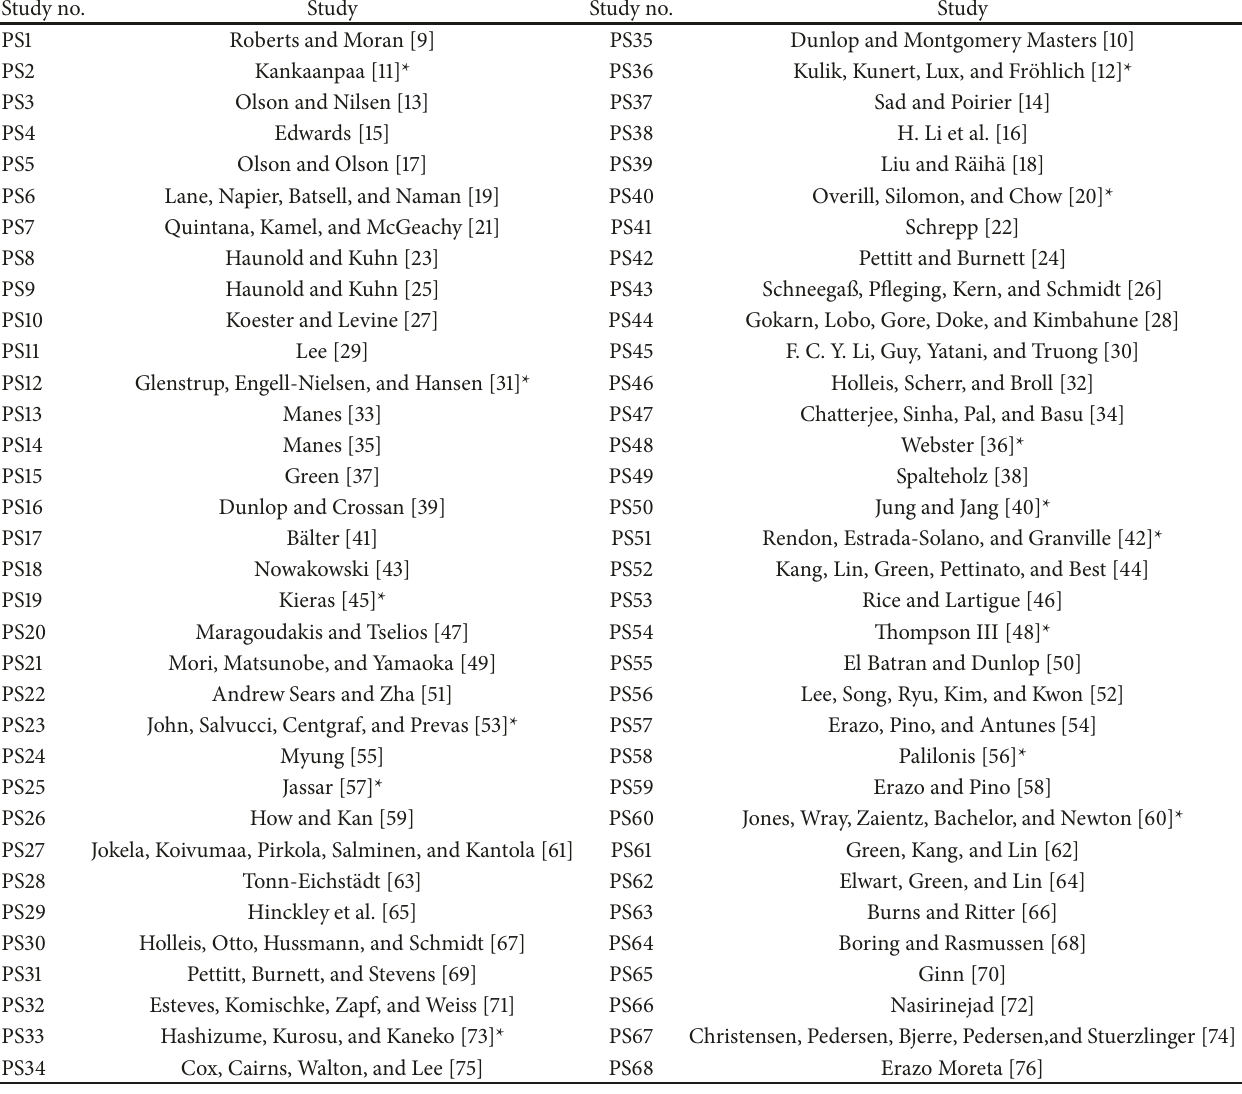
Table 6: Selected primary studies. The studies with a * were excluded based on the quality assessment results. Study no.